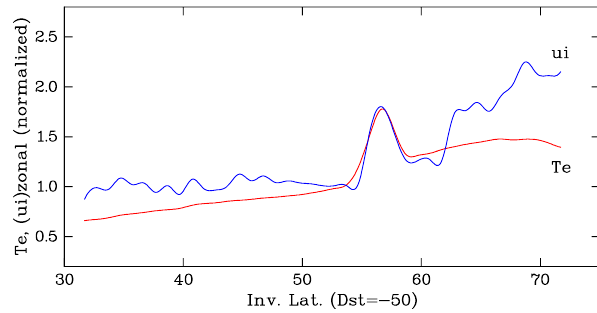
Fig. 14. Mean latitudinal profiles of the subauroral electron tem- perature enhancement (red line) and the associated zonal ion drift speed (blue line). The format of data presentation corresponds to that of Fig. 13 except that the electron density is replaced by the absolute value of the zonal ion drift